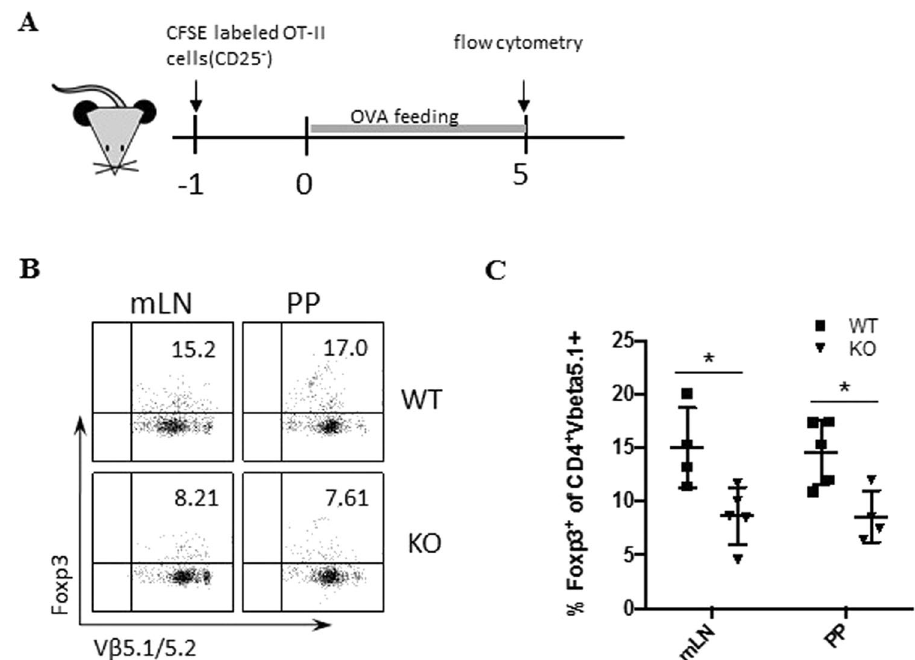
Figure 1. Effect of PD-1H in de novo generation of Foxp3 + iTreg cells. ( A ) Naïve T cells purified from WT OT-II or PD-1H KO OT-II mice were first labelled with 5 μ M CFSE and subsequently transferred i.v. to B6 mice at 2 × 10 6 /mouse. Mice were fed with 1.5% OVA in the drinking water 24 hours later for 5 days. Foxp3 frequency on the gated CD4 + CFSE + V β 5.1/5.2 TCR + was analysed by flow cytometry in the representative mice. ( B , C ) Summary of an experiment with each symbol representing an individual mouse (n = 5). Data shown are representative of 3 independent